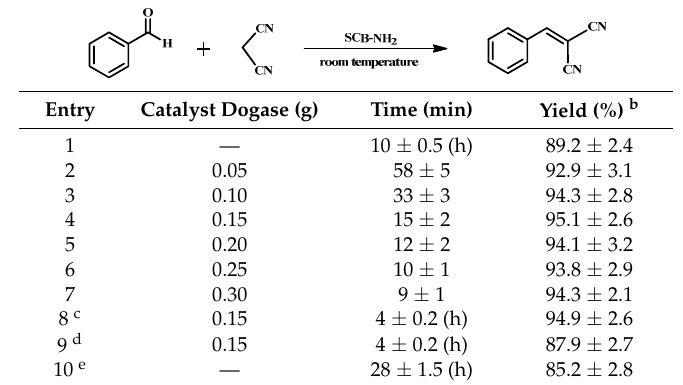
Table 2. The influence of the catalyst dosage a . Figure 4. SEM images of SCB ( a ), fresh SCB-NH 2 ( b ), and recovered SCB-NH 2 ( c ).